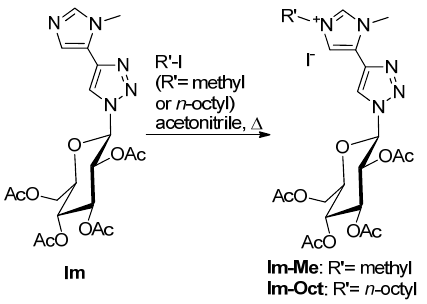
Figure 2. Structure of the complexes prepared within this study.